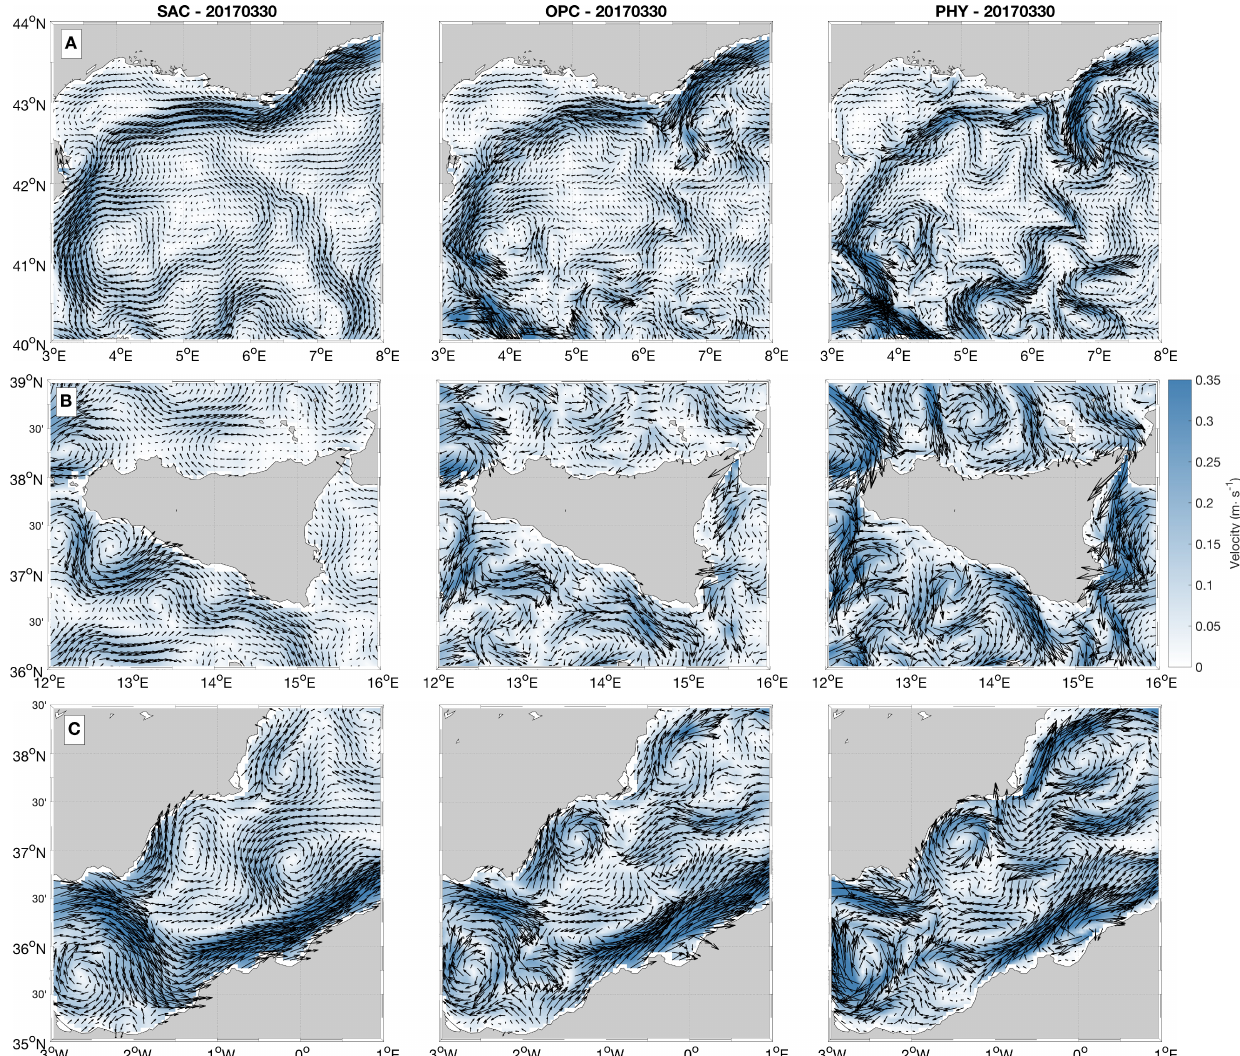
Figure 3. ( A ) Northwestern Mediterranean: left, middle and right panels, respectively, indicate the Synthetic Altimeter Currents (SAC), Optimal Currents (OPC) and CMEMS PHY modelled currents. ( B ) same as ( A ), with focus on the Sicily Channel. ( C ) same as ( A ), with focus on the Western